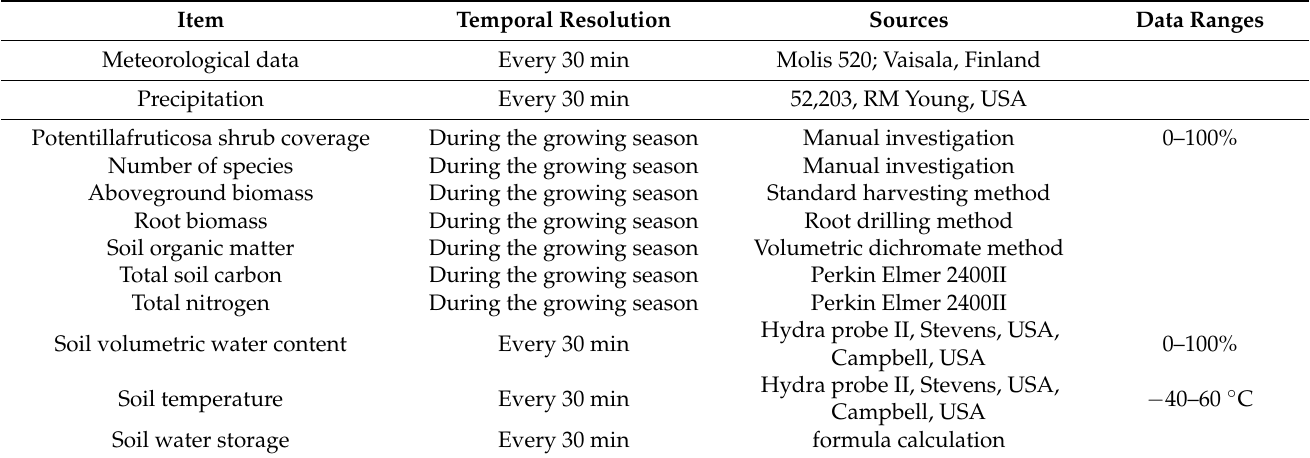
Table 3. The dataset information of alpine shrub meadow in this